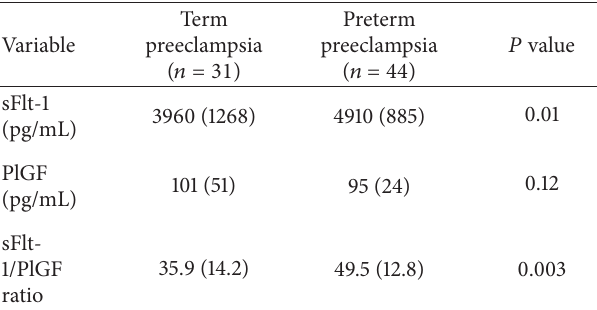
Table 3: Comparison of sFlt-1, PlGF, and sFlt-1/PlGF ratio in term and preterm preeclampsia.